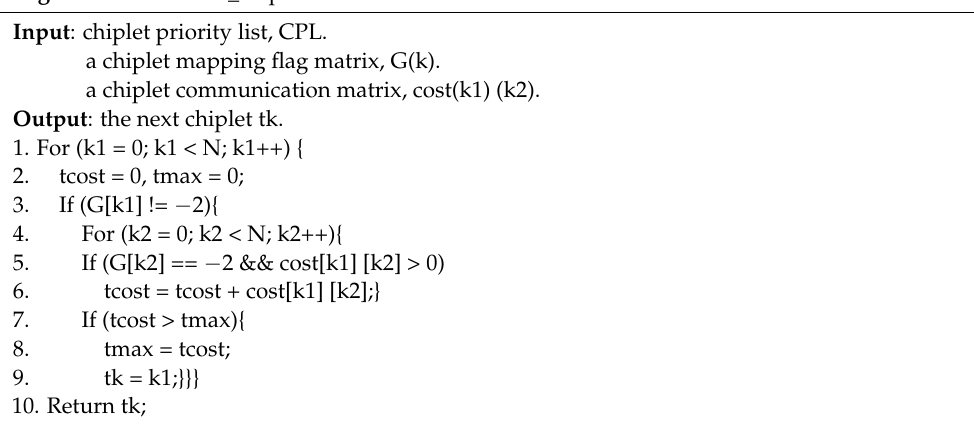
Algorithm 2 The next_chiplet function